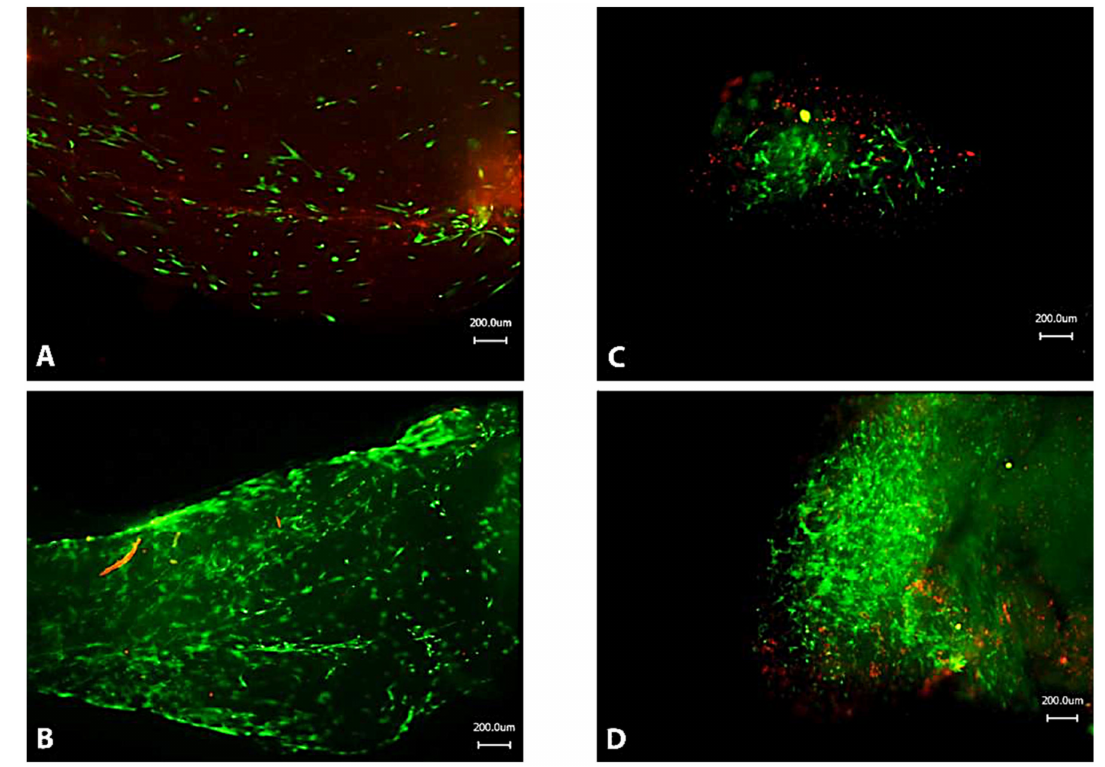
Figure 5. LIVE/DEAD-Assay of all experimental groups. Green fluorescent dye shows vital cells, red fluorescent dye indicates dead cells. ( A ) . Construct containing spider silk and bioreactor cultivation (experimental group A). ( B ). Construct without spider silk and with bioreactor cultivation (experimental group B). ( C ). Construct with spider silk and without mechanical stimulation (experimental group C). ( D ). Construct without spider silk and without mechanical stimulation (experimental group